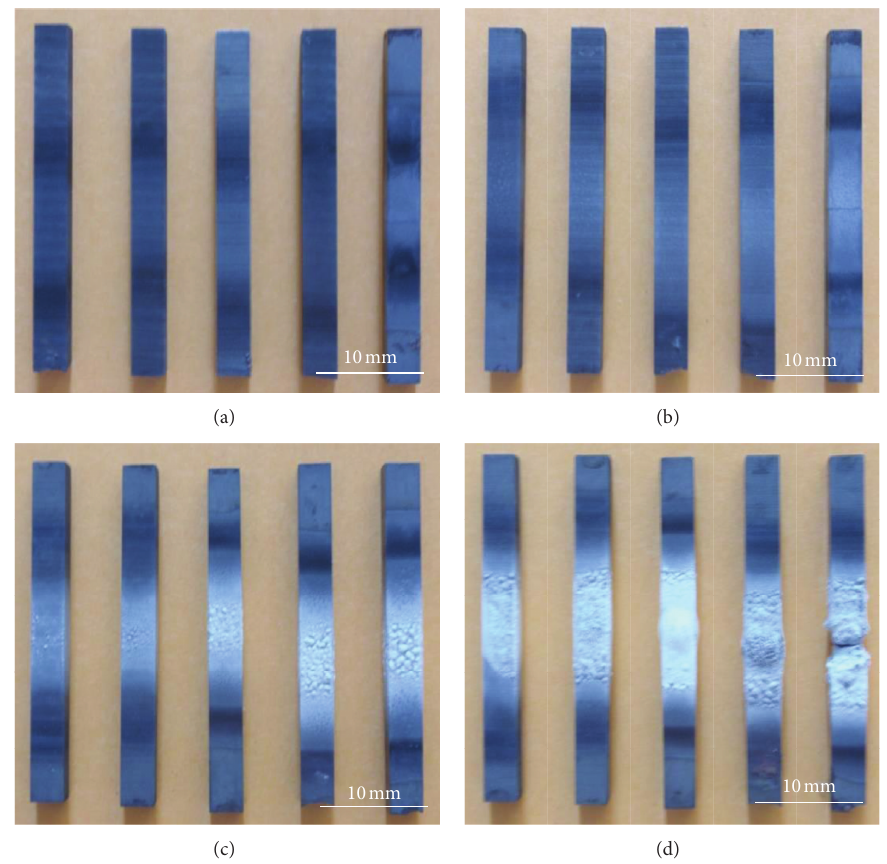
Figure 5: Macro photographs of ZSB materials after thermal shock for 10–50 times: (a) 1200 ∘ C; (b) 1400 ∘ C; (c) 1600 ∘ C; (d) 1800 ∘ C.